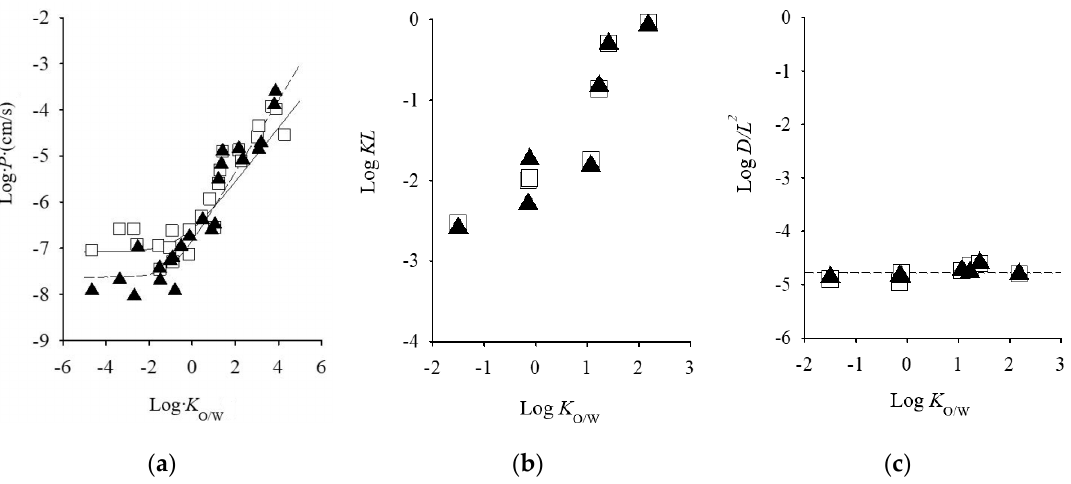
Figure 1. Relationship between skin permeation parameter of excised human cadaver skin and log K o/w values of chemical compounds. ( a ) log K o/w vs. log P , ( b ) log K o/w vs. log KL , and ( c ) log K o/w vs. log DL − 2 . Semi-solid line represents the calculated value: Symbols represents observed values. Symbols: ▲ ; human skin, □ : hairless rat skin. Cited from [28,34].